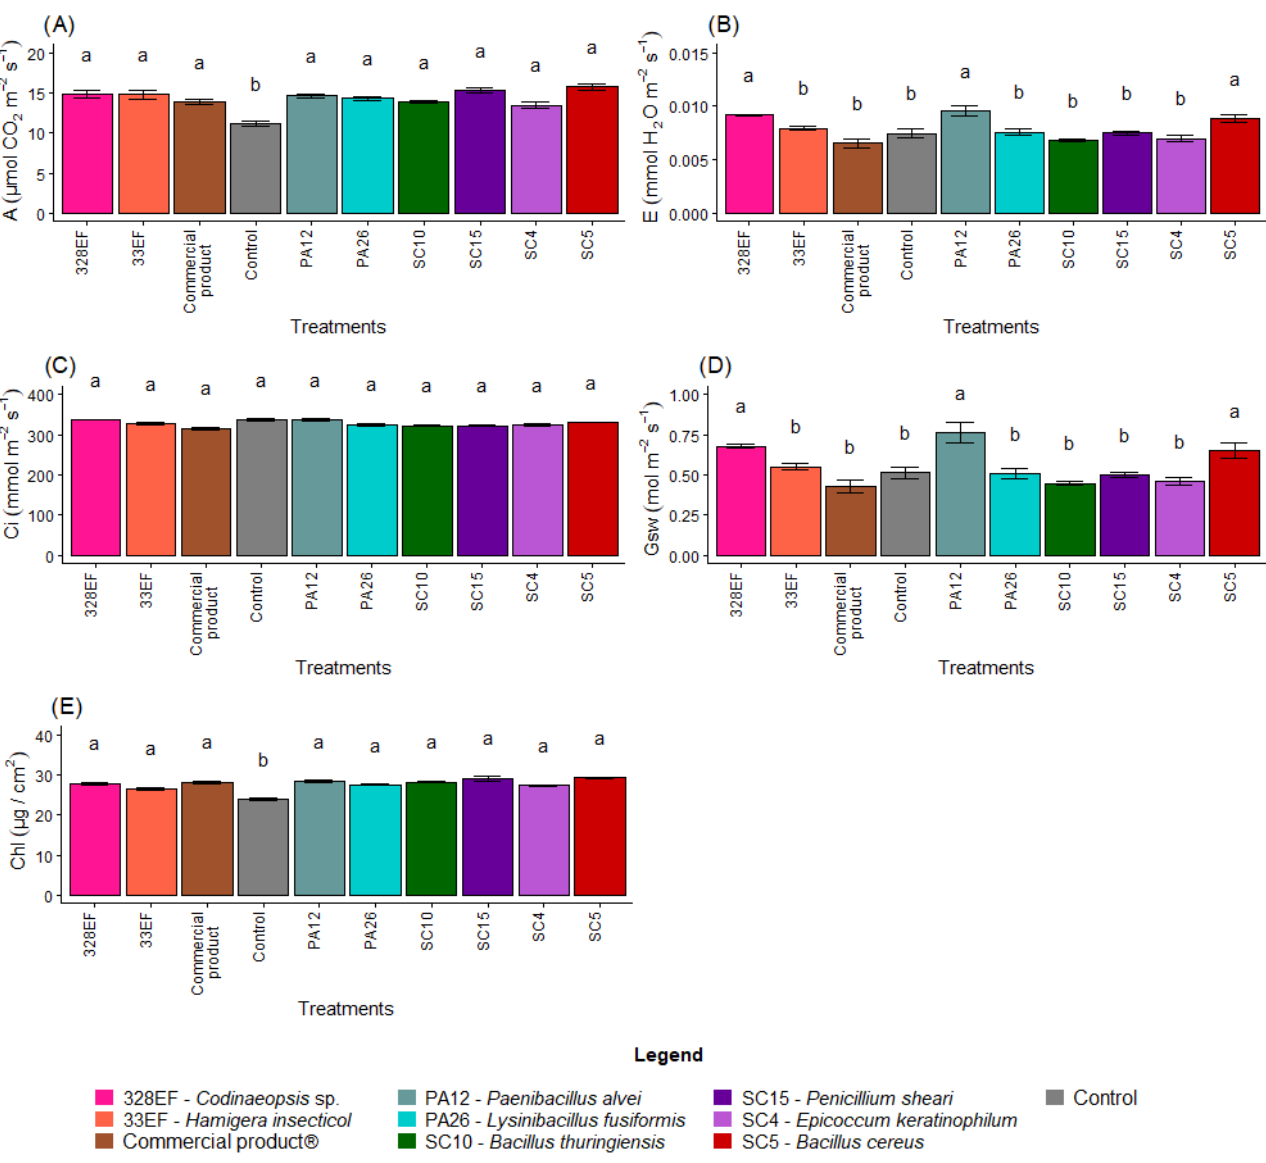
Figure 5. Photosynthetic rate, A ( A ); transpiration rate, E ( B ); internal concentration of CO 2, Ci ( C ); stomatal conductance, Gsw ( D ); and chlorophyll index ( E ) in soybean plants ( Glycine max ) inoculated with fungal and bacterial strains isolated from Hymenaea courbaril and Butia purpurascens and culti- vated in a controlled greenhouse system. Means followed by the same letter were not significantly different using the Scott – Knott test at 0.05% probability.